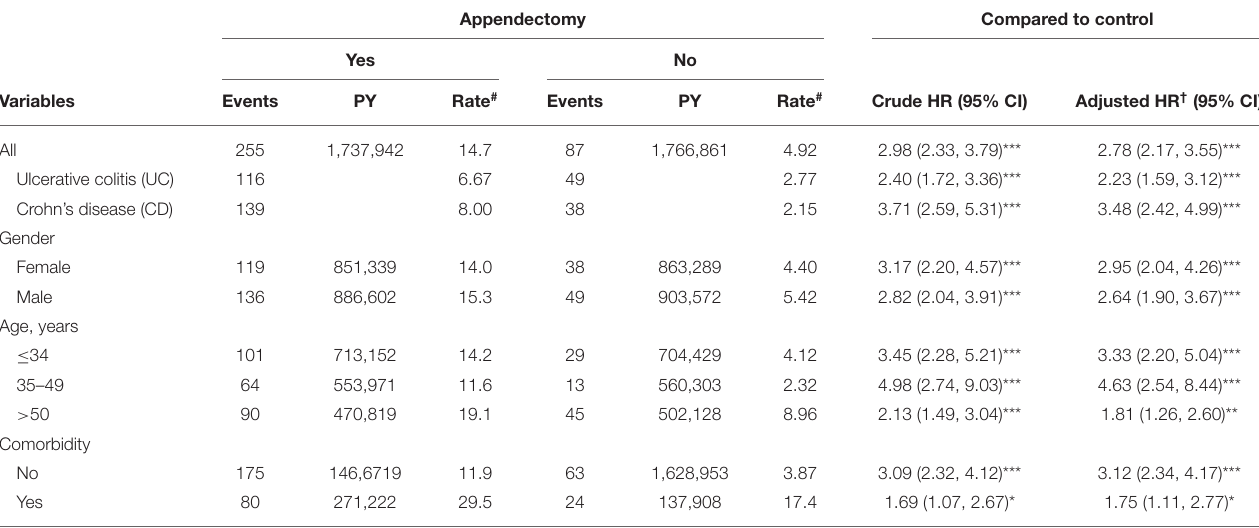
TABLE 2 | Incidence and adjusted hazard ratio of inflammatory bowel disease based on sex, age, and comorbidities for patients with appendectomy compared with controls. Appendectomy Compared to